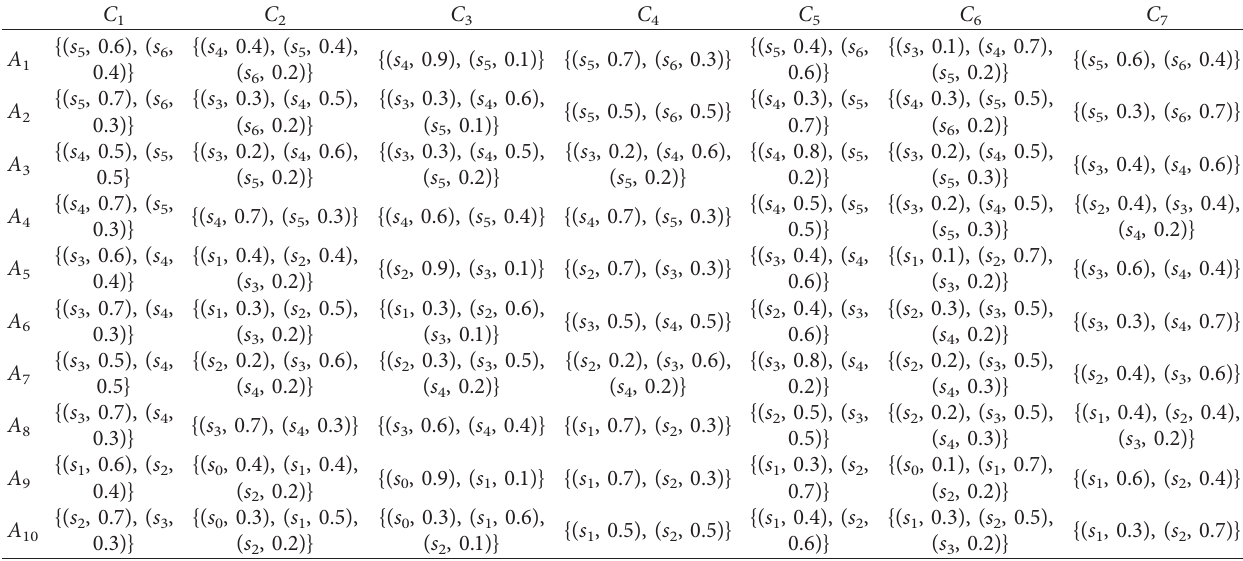
Table 4: The probabilistic decision matrix of judgment debtors.